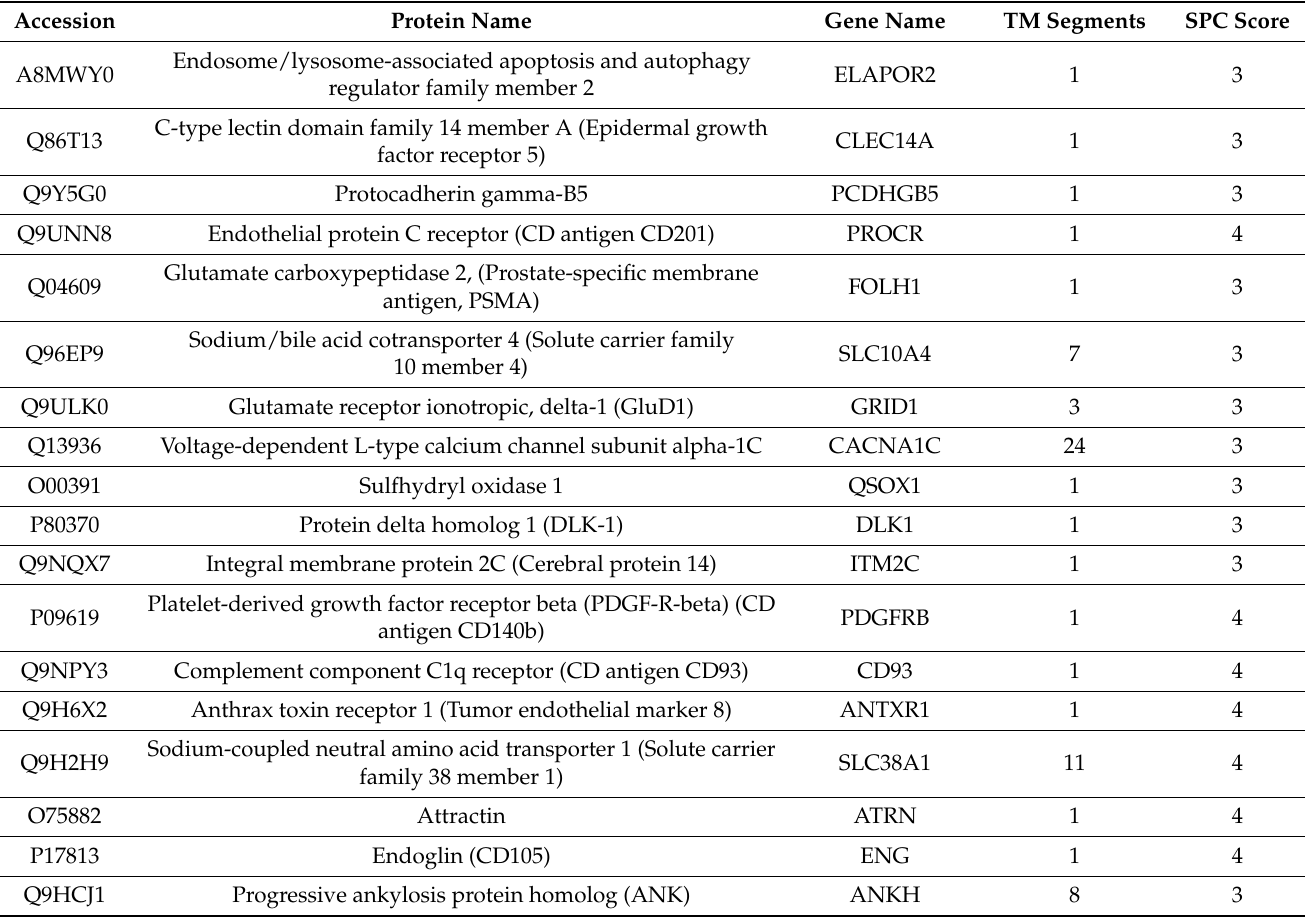
Table 2. Eighteen “tumor enriched” integral membrane proteins with cell surface localization were identified in all 5 PGLs but absent in the control adrenal medulla. “TM segments” indicates the number of predicted transmembrane segments/domains. Surface prediction consensus (SPC) scores of 3 or 4 indicate a high probability of cell surface